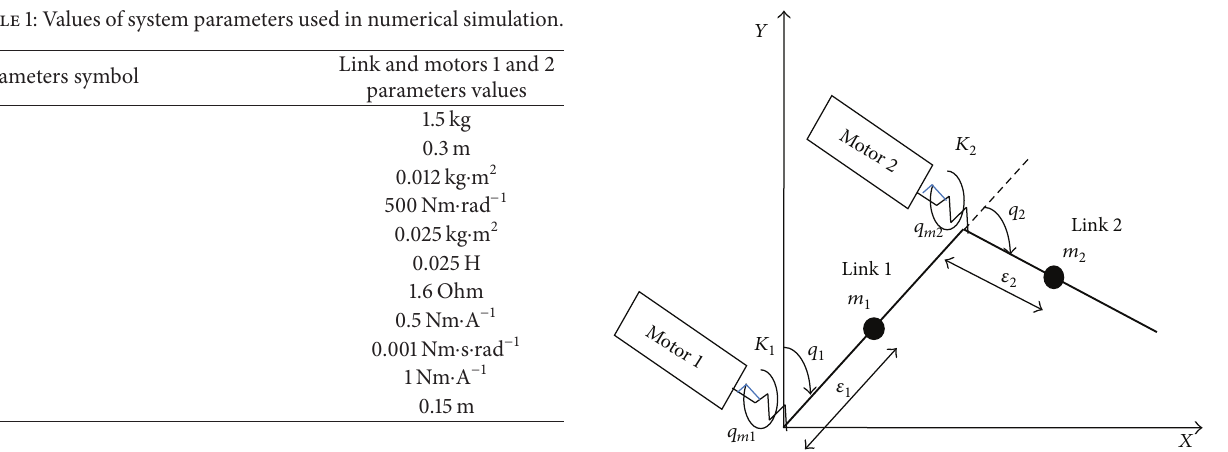
Figure 2: 2-DOF electrically driven flexible joint robot manipula-